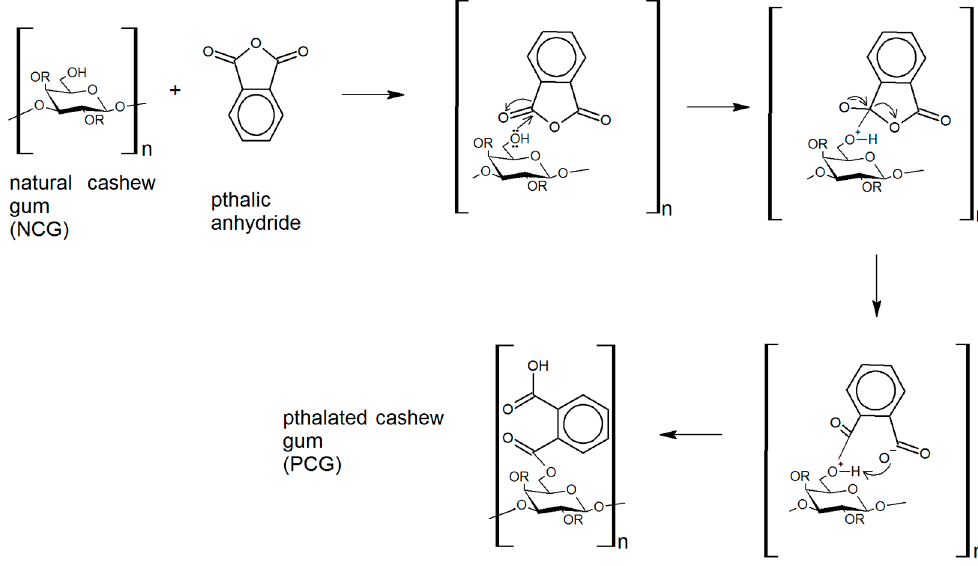
Figure 1. General reaction scheme for pthalation of cashew gum. The reaction proceeds via homogeneous esterification, with no side products.